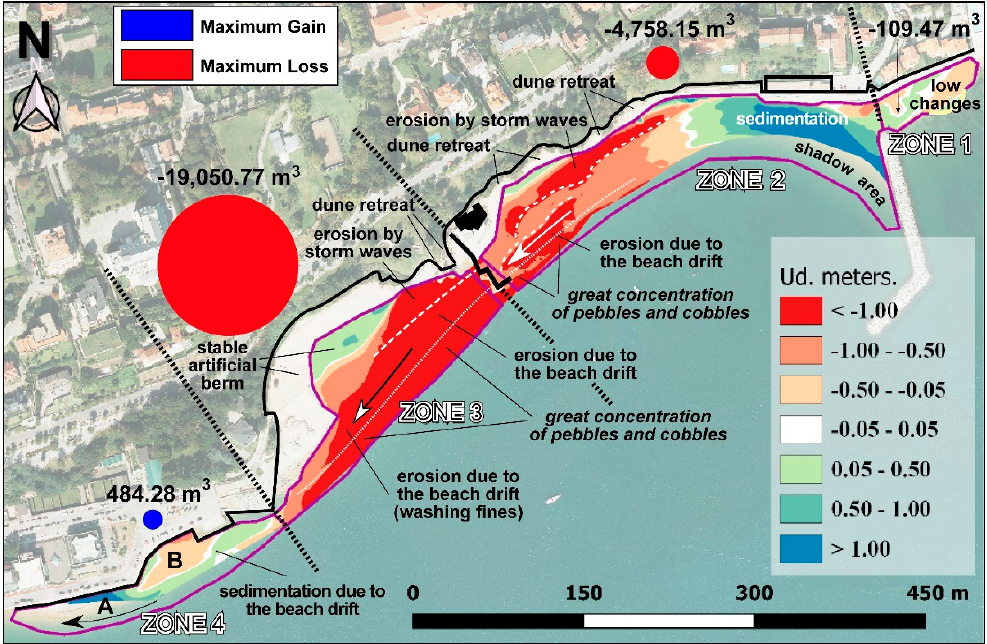
Figure 8. Synthesis of sedimentary balances between November 2018 and April 2021, and mor- phosedimentary dynamic trends; erosion occurred in the foreshore, backshore and dune fronts of Los Peligros and eastern La Magdalena, with main sedimentation in the sheltered area of the breakwater and the lobe of La Fenómeno. Persistent beach drift occurred southwestward.